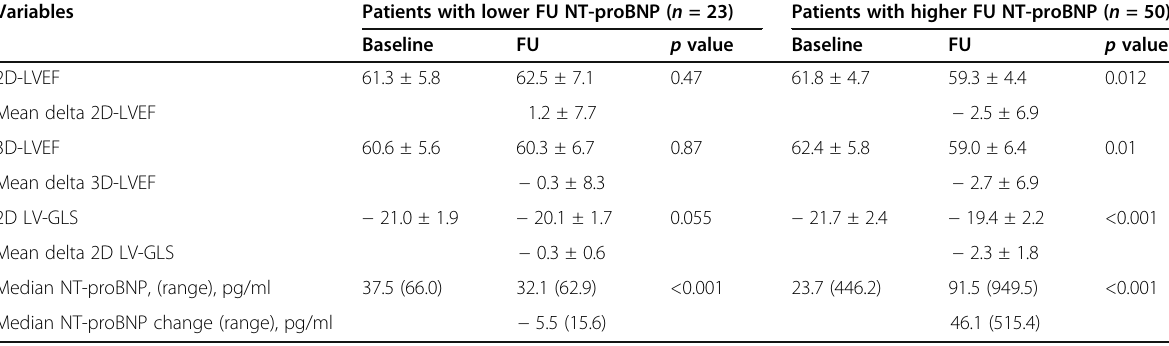
Table 5 Comparing patients who had lower versus those who had higher NT-proBNP at the follow-up visit